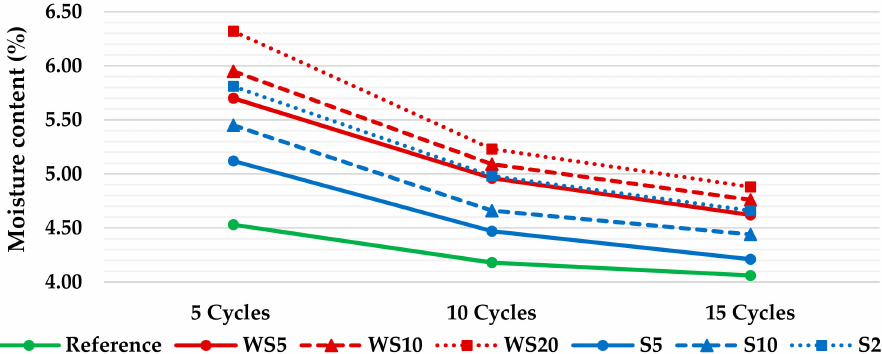
Figure 9. Moisture content evolution of the plasters during the